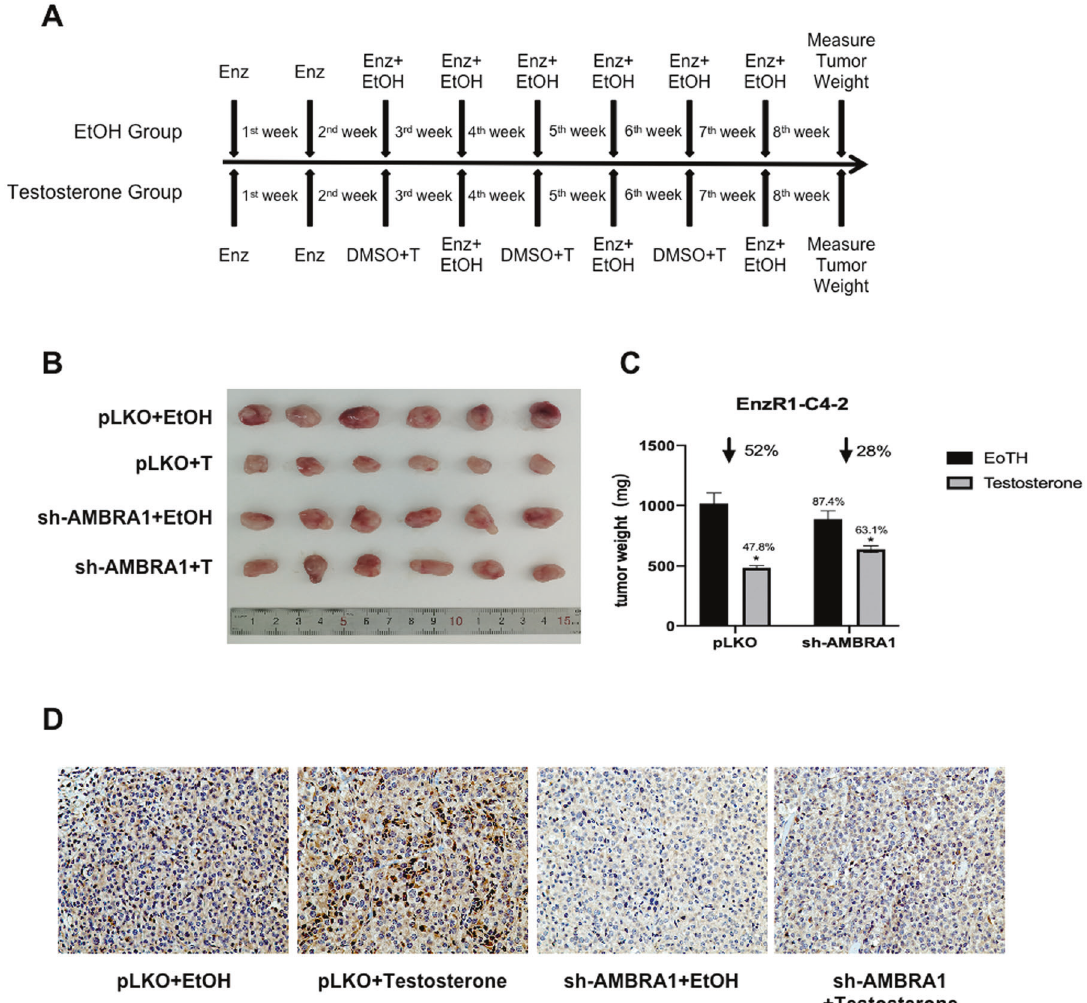
Fig. 6 Preclinical study using In vivo mouse model to con fi rm the role of DHT and AMBRA1 in EnzR cell growth. A Equal numbers of EnzR1-C4-2 cells (5 × 10 6 cells) were subcutaneously injected into each mouse to establish the CRPC xenograft model. Mice were injected with Enz (10 mg/kg/week, twice weekly). Bipolar androgen therapy treatment was conducted by injection of Testosterone (200 μ g/kg/week, twice weekly) or EtOH at the 3th/5th/7th week. Mice were euthanized after 8 weeks and tumors were removed for studies. B , C Tumor weights ( B ) were shown and presented as means ± SD ( C ). D Representative IHC images of AMBRA1 expression in tumor tissue samples from the 4 groups, ×200 magni fi cation. * p <